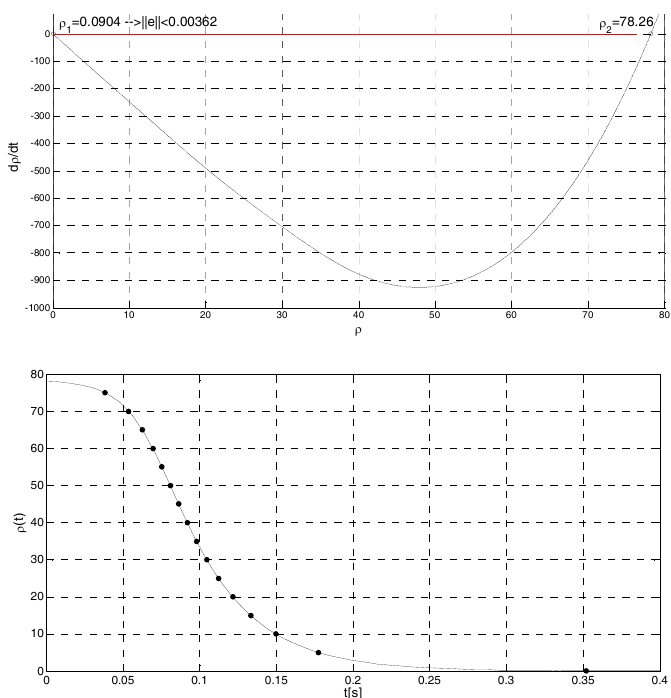
Figure 19. Function ρ = f ( ρ ) and time histories of ρ ( t ) of the majorant system with the controller in (68).